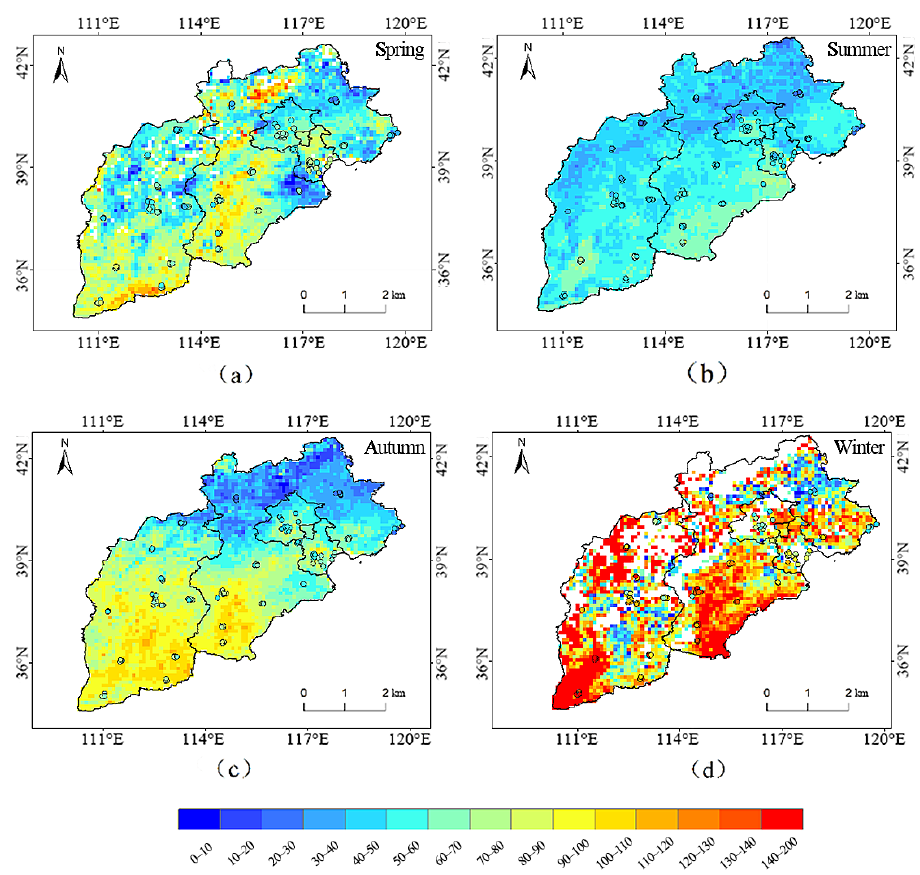
Figure 6. Comparison of the seasonally averaged PM 2.5 mass concentration values of Beijing–Tianjin–Hebei–Shanxi in 2017 and ground observation points. ( a ) Spring, ( b ) Summer, ( c ) Autumn, ( d ) Winter.